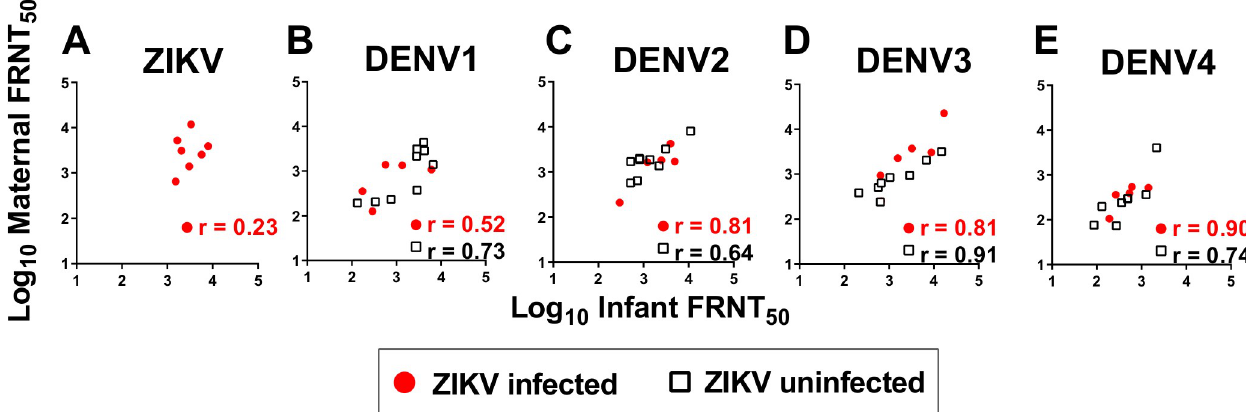
Fig 5. Maternal ZIKV infection does not disrupt transplacental transfer of DENV neutralizing IgG. Kendall Tau correlation of focus neutralization reduction titer-50 (FRNT-50) for maternal plasma and infant cord blood, separated by maternal ZIKV serostatus. Panels indicate correlation of maternal and infant neutralizing titers by flavivirus: ZIKV (A), DENV1 (B), DENV2 (C), DENV3 (D) and DENV4 (E). All correlations are P < 0.05, except DENV1 and ZIKV in ZIKV-infected mothers where P < 0.09 and P < 0.45 respectively.